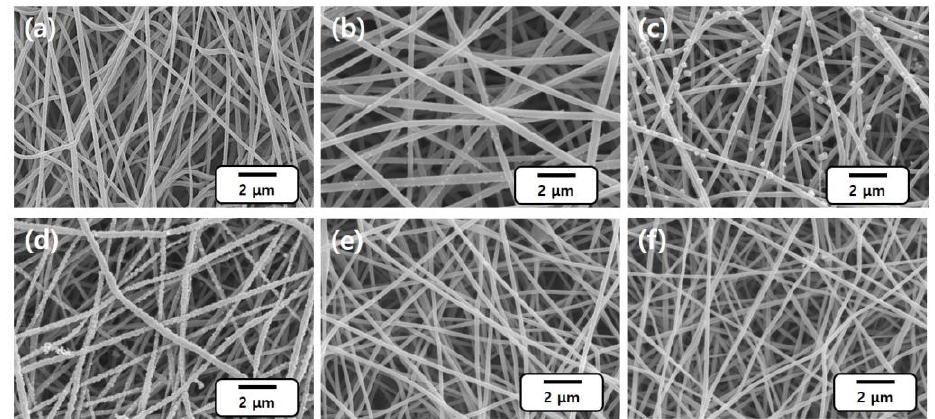
Figure 1. Morphology change of CNFs (carbon nanofibers) through chemical deposition in different